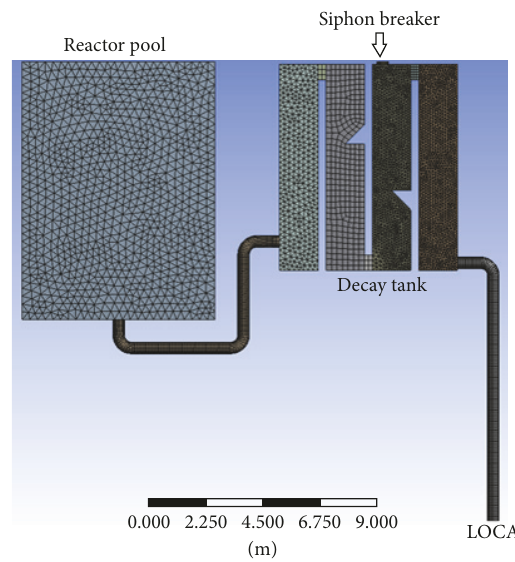
Figure 8: Mesh modeling for siphon breaker